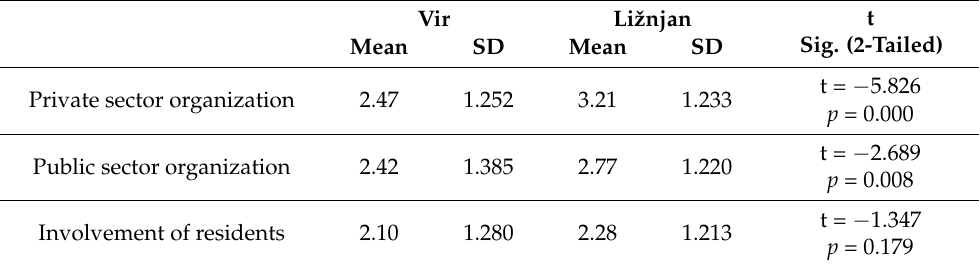
Table 5. Results of